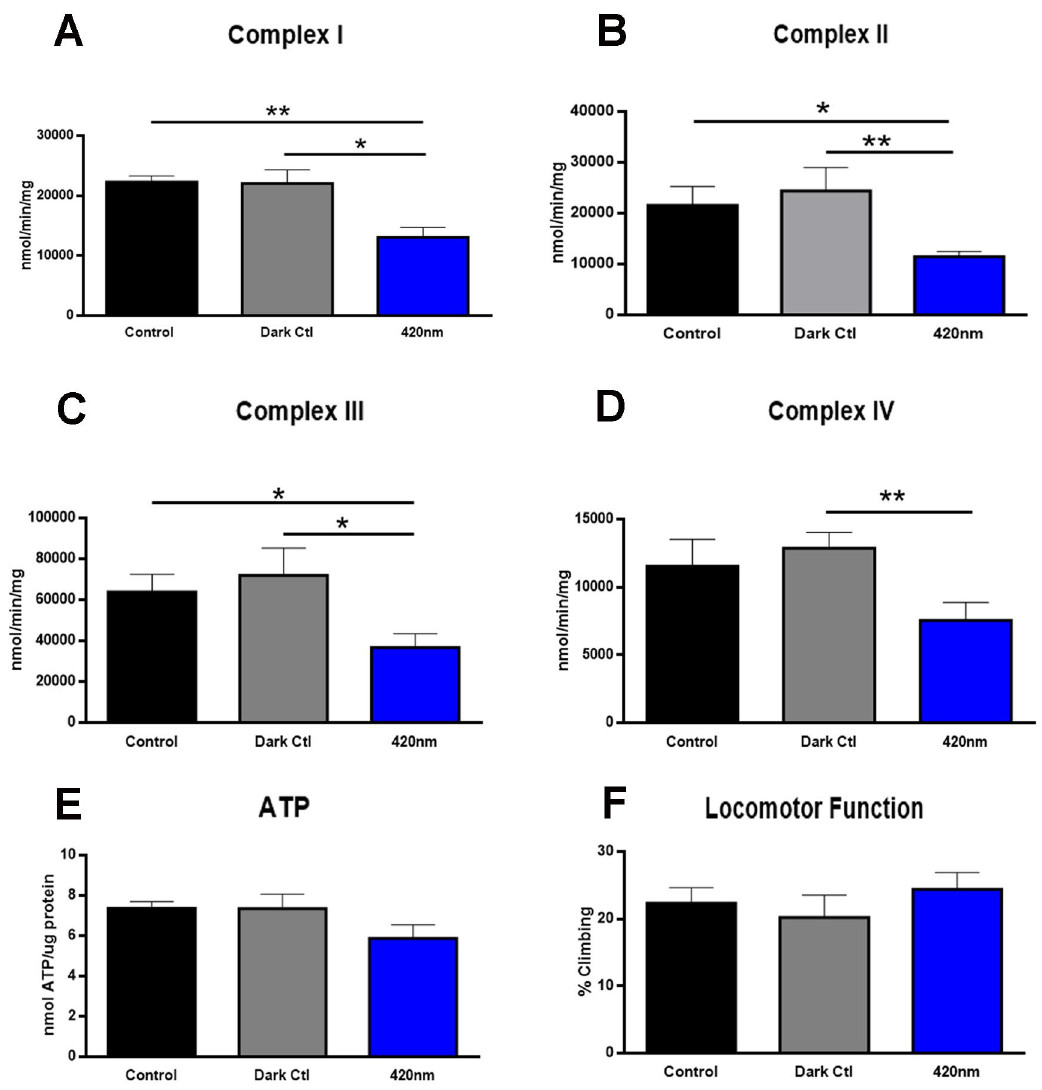
Fig 2. Mitochondria complex activity (A-D) for I, II, III and IV was measured after 420nm (Blue) light exposure for 15 mins daily over 1 week. Blue histograms are vials exposed to 420nm LED light for 15 mins daily for 7 days. Black histograms represent controls where vials were exposed to 12/12h standard light condition and grey histograms are vials were shielded from light by aluminium foil. 420nm significantly reduce the activity of each complex when compared to both controls (A-D). Level of ATP (E) was reduced with 420nm, but this was not significant. Locomotor function (F) did not change for 420nm treated flies. Hence 420nm significantly impacted on mitochondrial complex activities, but this did not translate to reduced function of the organism. Abbreviations: � p < 0.05, �� p <